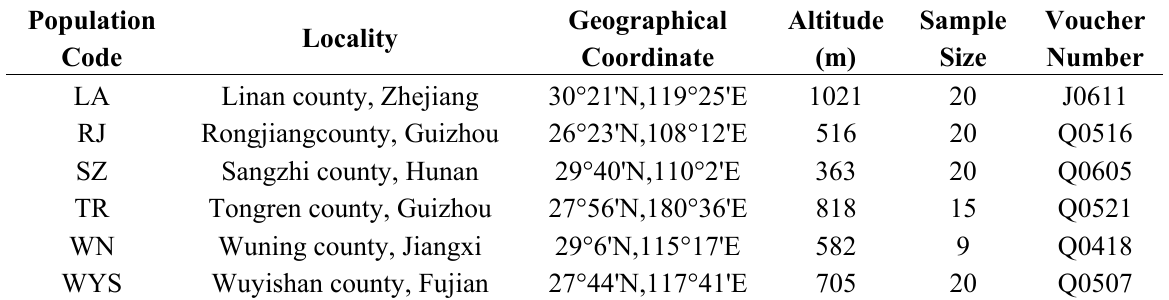
Table 5. Sampling details of different populations of C. tsoongiana in this study.